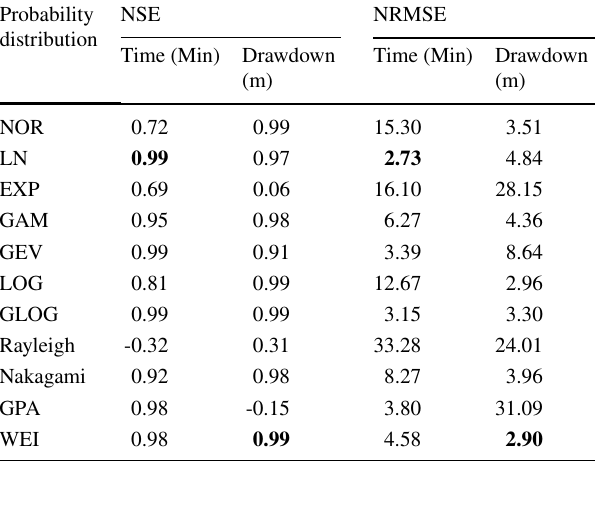
Table 3 Results of marginal distributions of values of groundwater drawdown and pumping time with a discharge of 28.8 l/s Probability NSE distribution